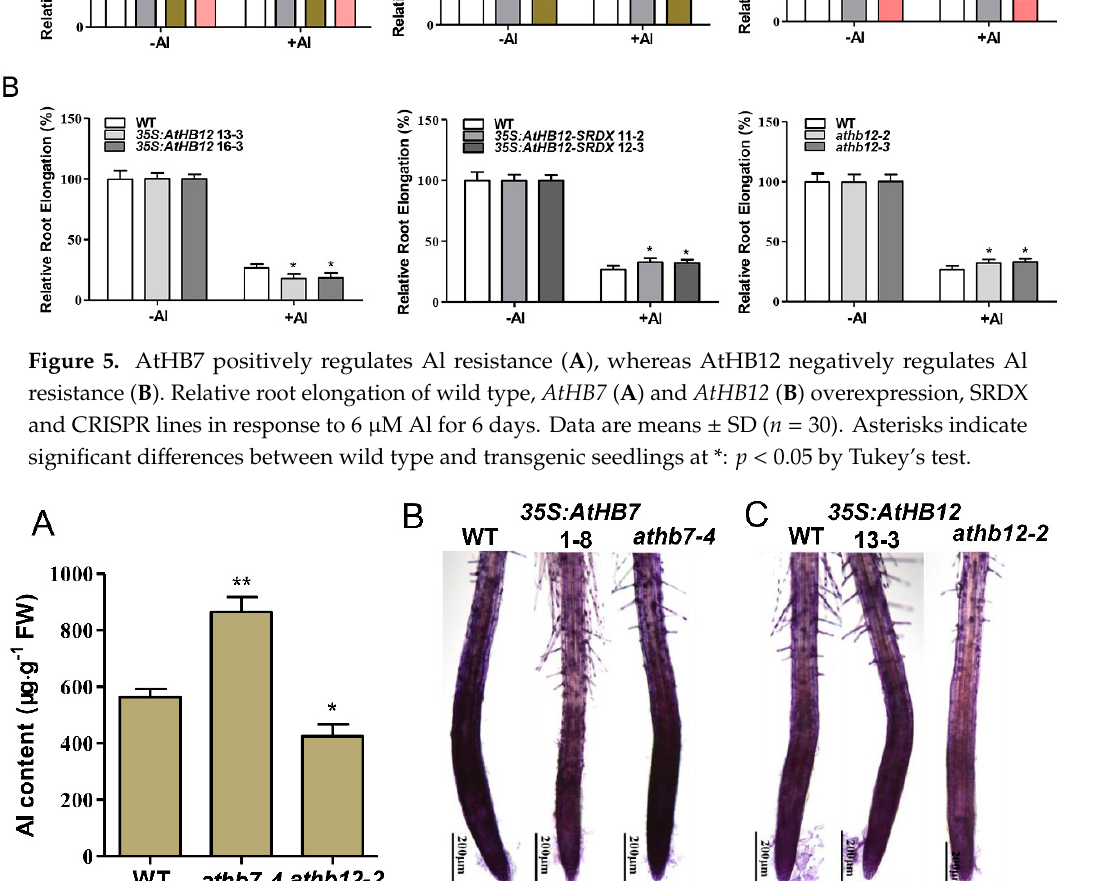
Figure 7. AtHB7 and AtHB12 might act in homodimer or heterodimer in response to Al stress. ( A ) AtHB7 and AtHB12 could form homodimer and heterodimer showed by yeast two-hybrid assay. ( B ) Relative root growth of wild type, athb7 , athb12 and athb7/athb12 double mutant in response to Al treatment. Data are means ± SD ( n = 30). Asterisks indicate significant differences between wild type and mutants at *: p < 0.05 by Tukey’s test. 3. Discussion Al stress in one of the most limiting factors for plant growth and crop productivity in acidic soils. Identification of the molecules involved in Al tolerance mechanisms is a current challenge for Al toxicity. Previous studies identified STOP1 as a key transcription factor that regulates primary root